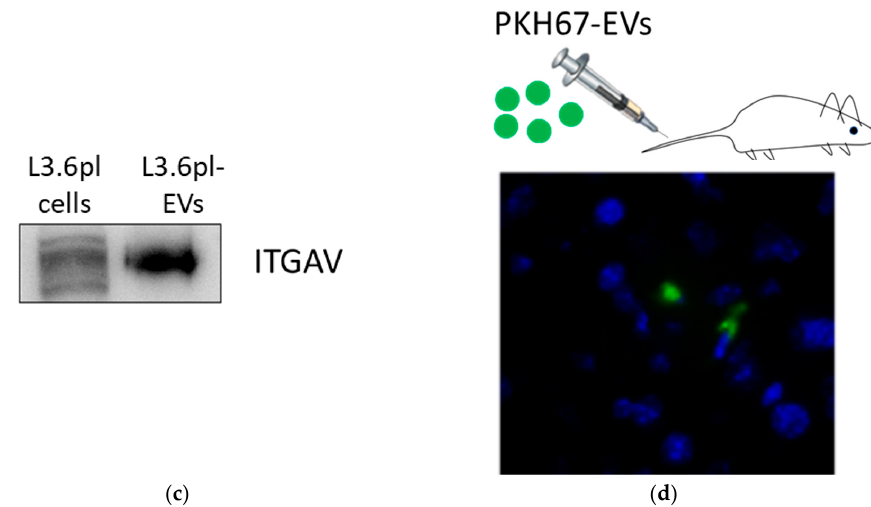
Figure 3. Pancreatic cancer-derived EVs carry adhesion molecules. ( a ) Heatmap of adhesion molecules in L3.6pl-derived EVs and TBO368-derived EVs, exosomal markers CD9, CD63, and CD81 as internal references. ( b ) Integrins in L3.6pl-derived EVs and TBO368-derived EVs. ( c ) Western blot analysis of ITGAV in L3.6pl-derived EVs. ( d ) Analysis of liver injected with PKH67-labeled L3.6pl-derived EVs (green) by confocal microscopy. Nuclei were stained with DAPI (blue).